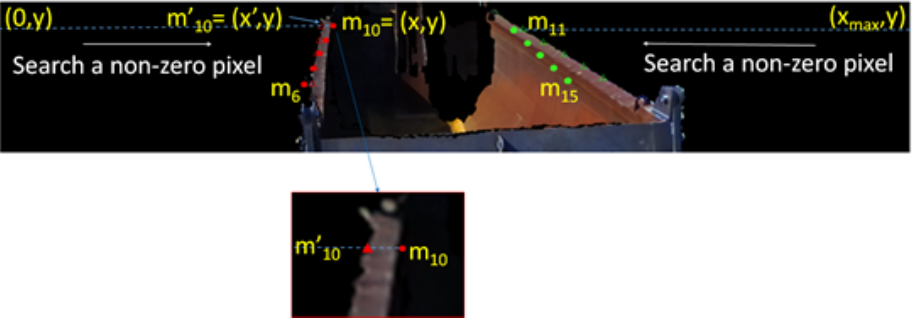
Figure 17. A method of selecting the correspondence point of the truck cargo box from the corners.